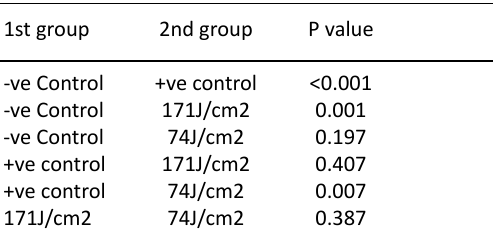
Table 11. Head circumferences comparison in day three between every pairs